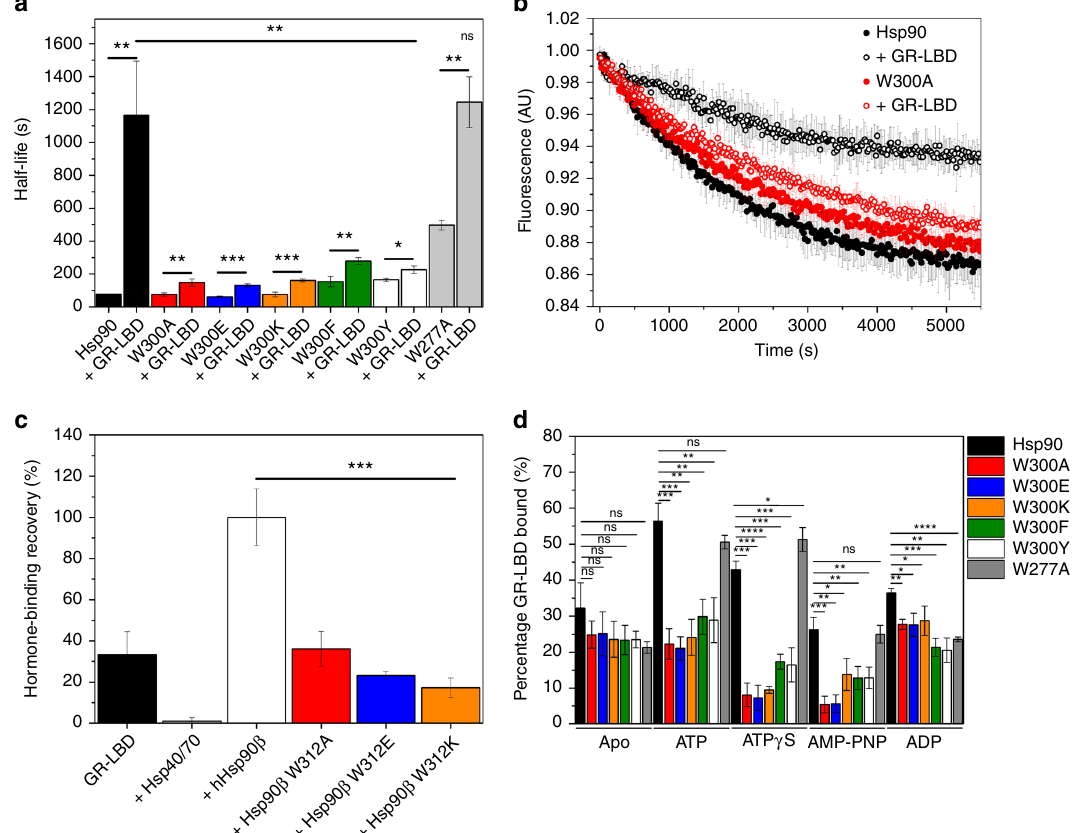
Fig. 3 Conformational effects of mutations of the conserved tryptophan. a Closing reaction of the FRET hetero-dimer; closing of the wt/mutant Hsp90 dimer was monitored after addition of ATP γ S in the presence and absence of the GR-LBD. Mean reaction half-lives from three independent measurements were derived from the original traces and plotted ( n = 3). Standard deviations based on three independent measurements are indicated. Statistical signi fi cance was assessed using a two-sample t -test and a level of signi fi cance of 0.05. b Chase experiments with the closed wt/W300A Hsp90 dimer in the absence and presence of the GR-LBD. Chase experiments were initiated by the addition of unlabeled wt Hsp90. The mean fl uorescence and standard deviations of three independent measurements were plotted ( n = 3). c Fluorescence anisotropy hormone-binding recovery measurements with human Hsp90 β W312 mutants; normalized mean fl uorescence anisotropy end values of the binding kinetics were normalized to the value in the presence of the full chaperone system and wt human Hsp90 β . The measurements were performed in triplicates ( n = 3). Error bars indicate standard deviations from three independent measurements. Statistical signi fi cance was assessed using a two-sample t -test and a level of signi fi cance of 0.05. d AUC-analysis of GR-LBD binding to Hsp90 W300 mutants in different nucleotide states; bars indicate mean amount of labeled GR-LBD found in the Hsp90/mutant complex in the presence of Hsp90 and indicated nucleotides. Measurements were performed in triplicates to rule out experimental fl uctuations ( n = 3). Error bars represent standard deviations from three independent measurements. Statistical signi fi cance was assessed using a two-sample t -test and a level of signi fi cance of